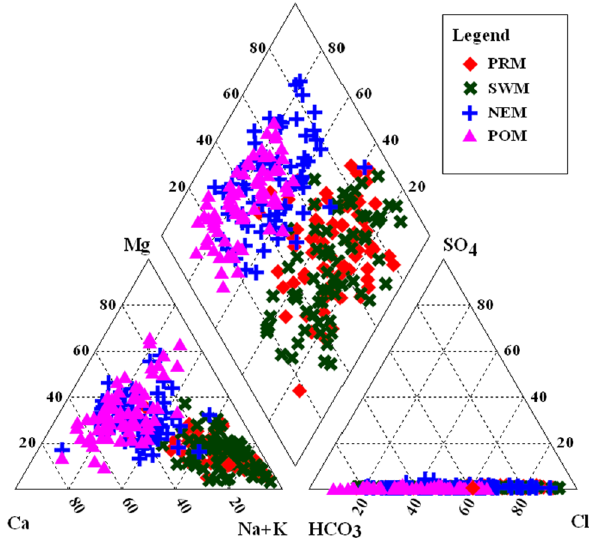
Fig. 9 Piper plot representation of samples from four different sea-